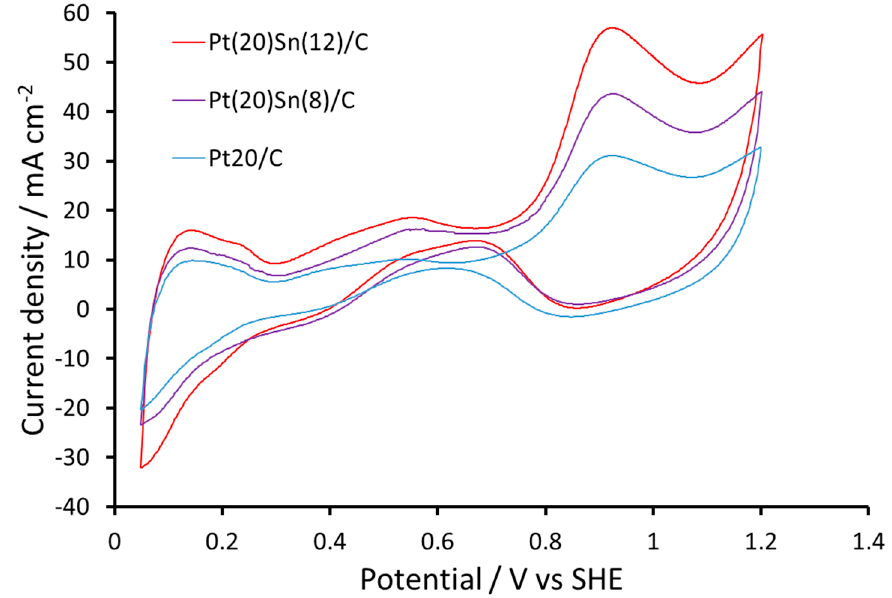
Figure 5. Cyclic voltammograms of EtOH oxidation on electrodes with different catalysts obtained in 0.1 M EtOH solutions (Ar purged) with 0.5 M H 2 SO 4 as the supporting electrolyte at 50 mV/s sweep rate. Currents are normalized to electrode geometric surface area.